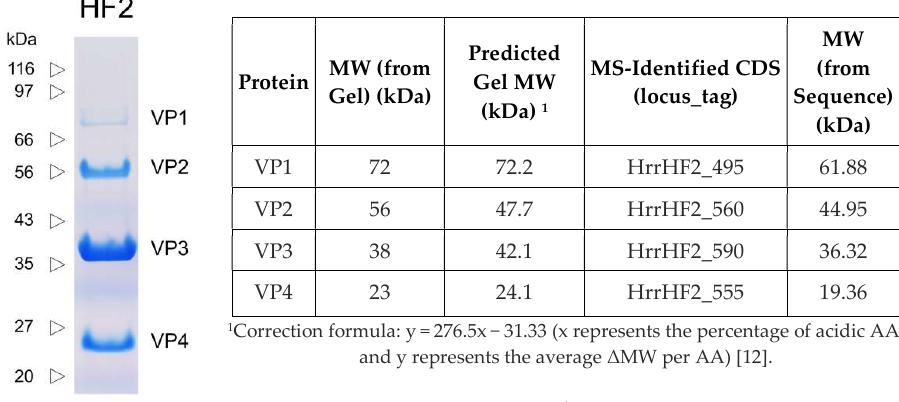
Figure 3. ( a ) SDS-PAGE of HF2 proteins (Coomassie Blue stained). ( b ) Molecular weights and identified genes of VP1-VP4. genes of